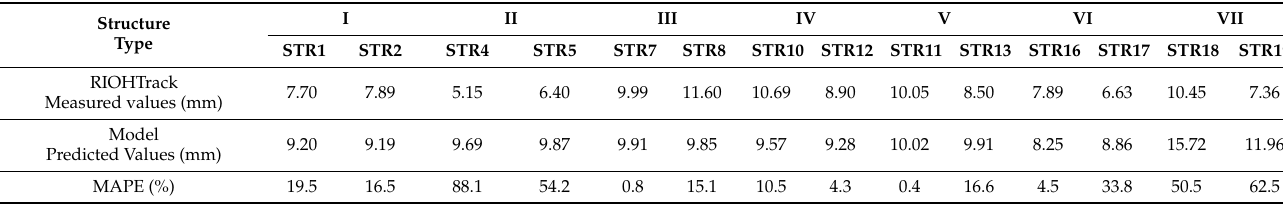
Table 3. Rutting values at the end of design